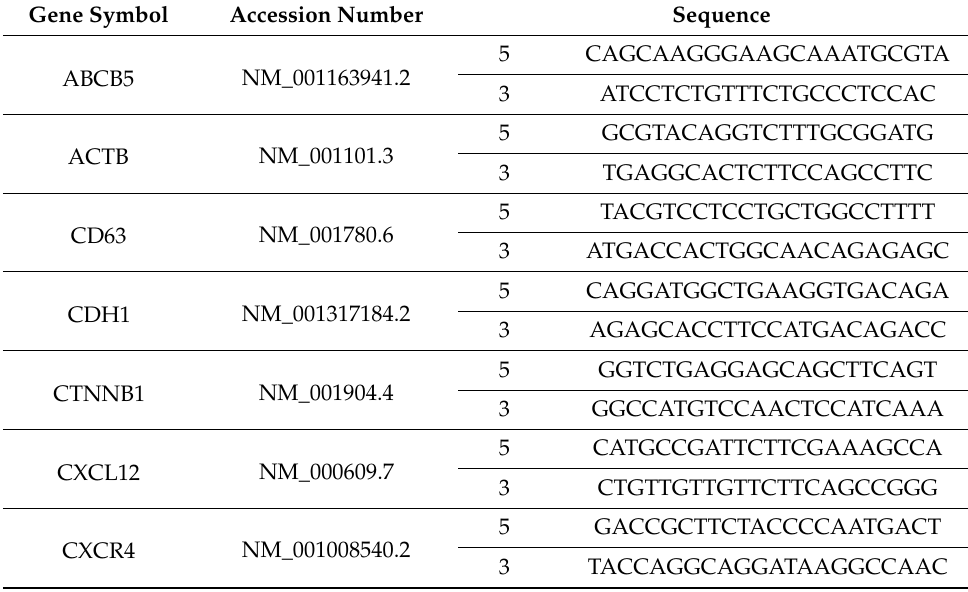
Table 2. Primers used in qRT-PCR primer